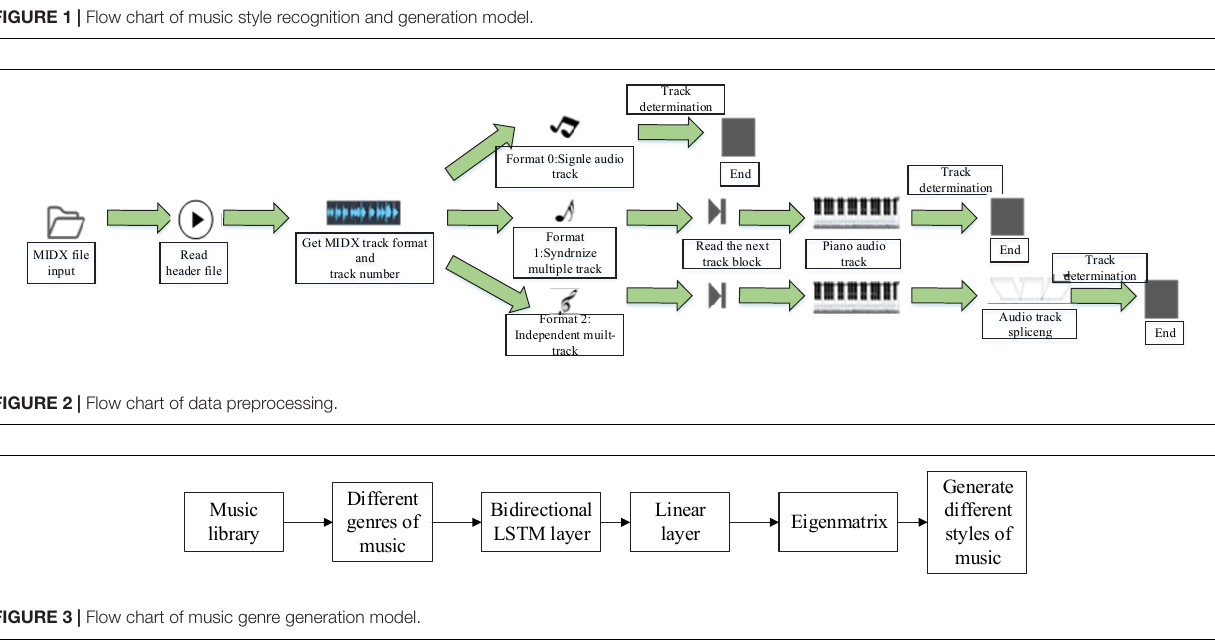
FIGURE 1 | Flow chart of music style recognition and generation model.